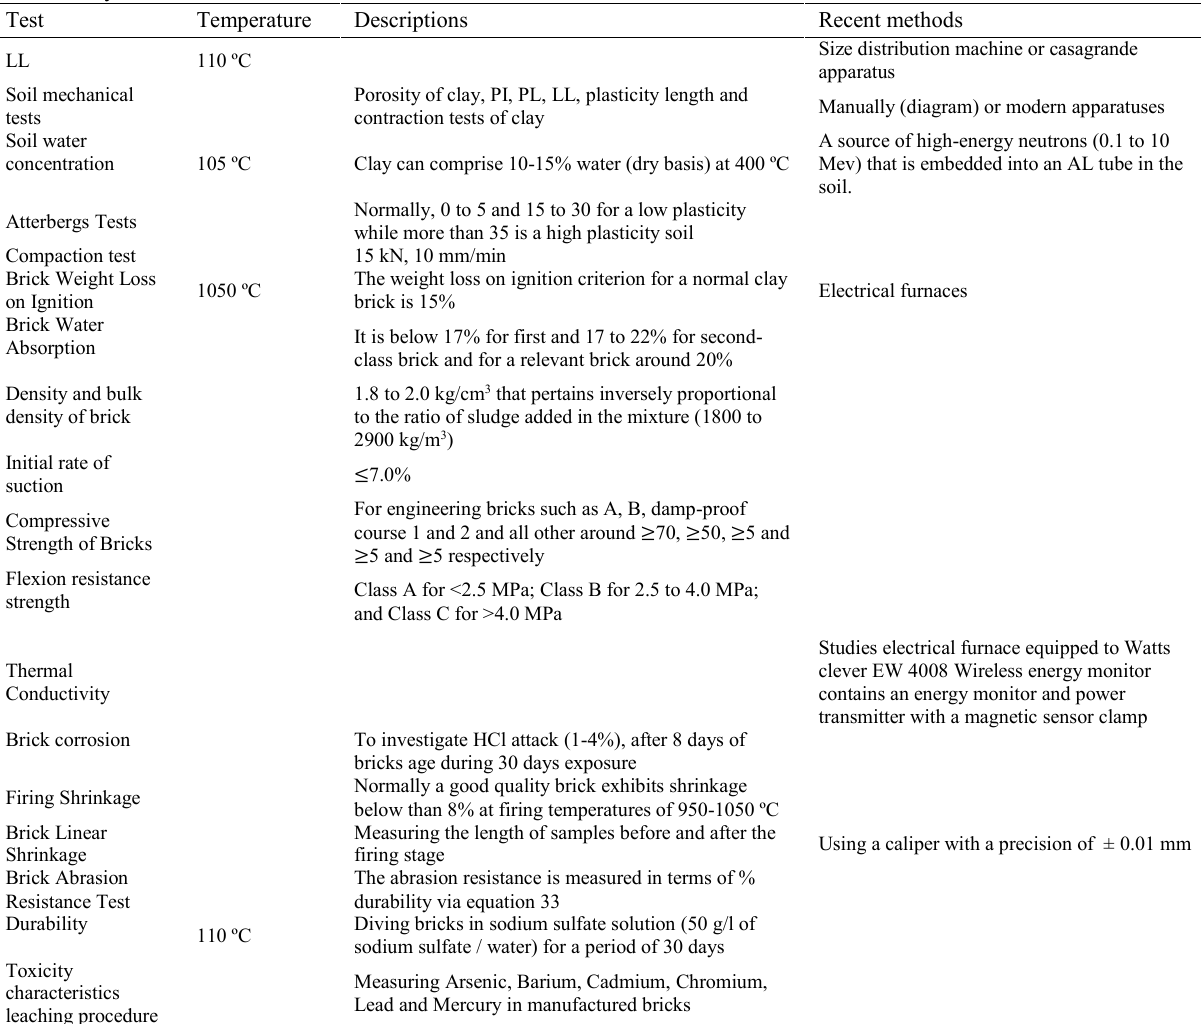
Table 4. Physical tests of bricks